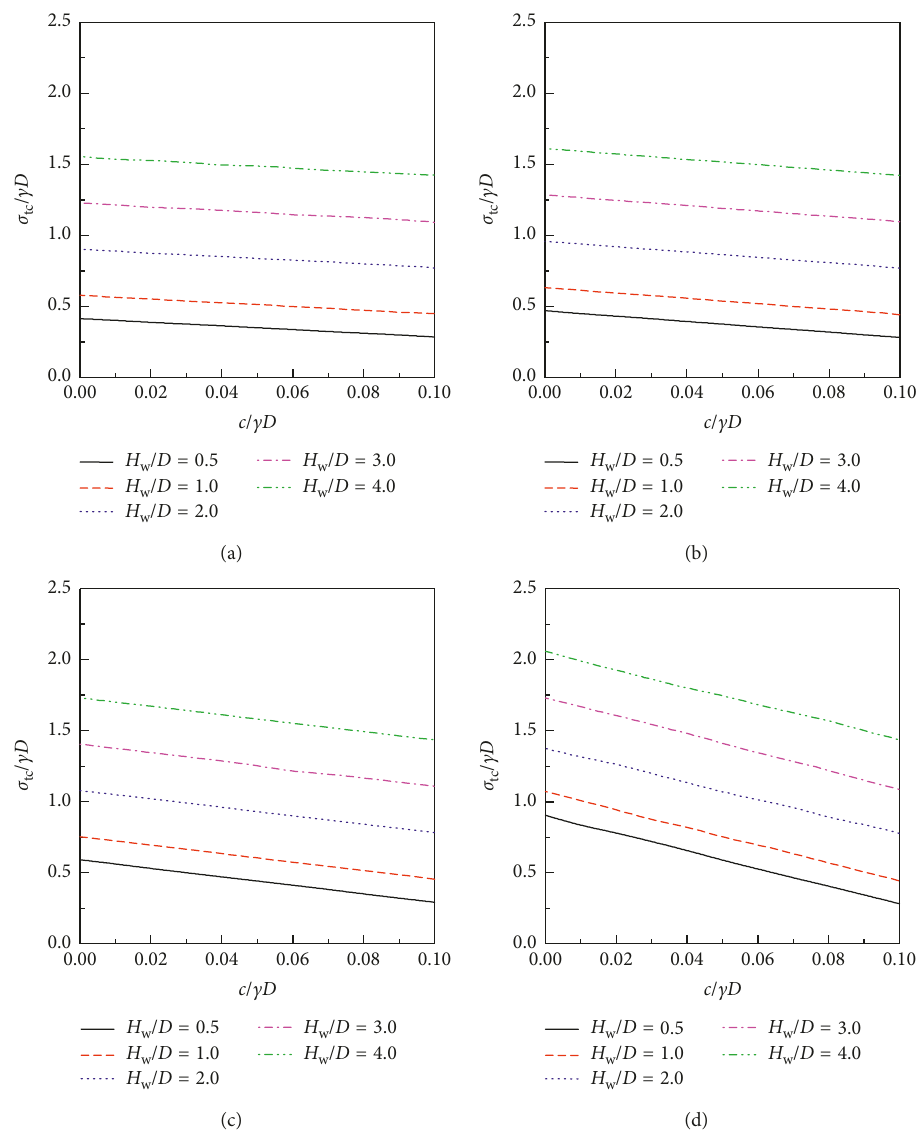
Figure 13: Stability charts of the critical pressure supported on the tunnel face under the pore water pressure r 10 ° (c) φ 20 ° . (d) φ (cid:29) (cid:29)